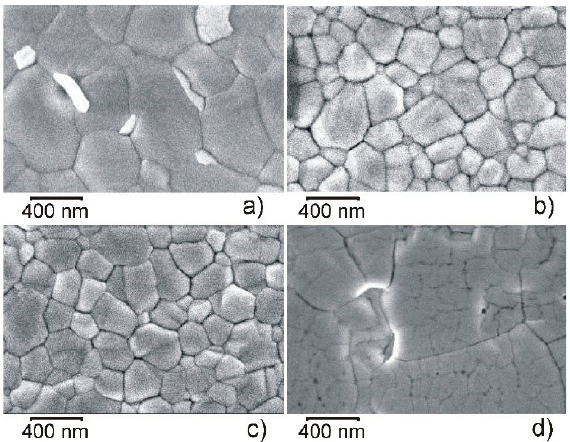
Figure 2. Surface SEM images of the formed perovskite films. Cs concentration (in %) is: ( a ) 0, ( b ) 10, ( c ) 20, ( d ) 40. Magnification is 100,000 ×